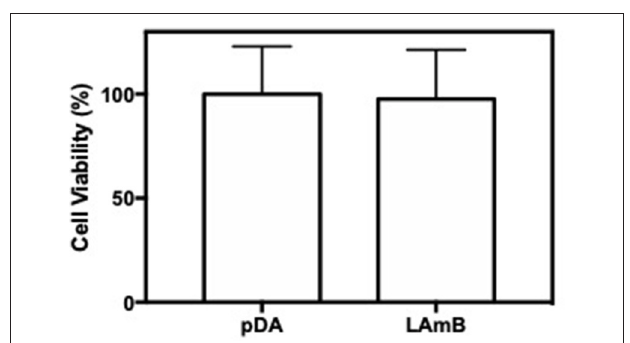
FIGURE 5 | Surfaces biocompatibility. Viability of 3T3 fibroblast cells after 48h of contact with pDA-coated PDMS surfaces before and after functionalization with LAmB, measured with an MTS assay. No significant differences were